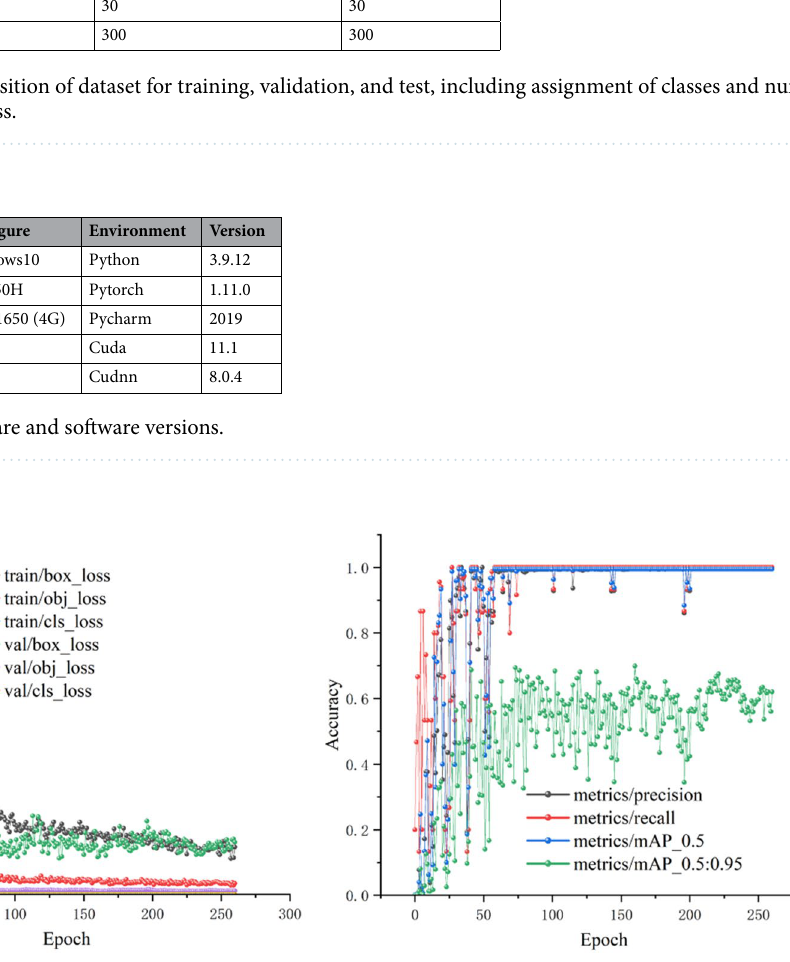
Figure 7. Convergence results of the pre-training